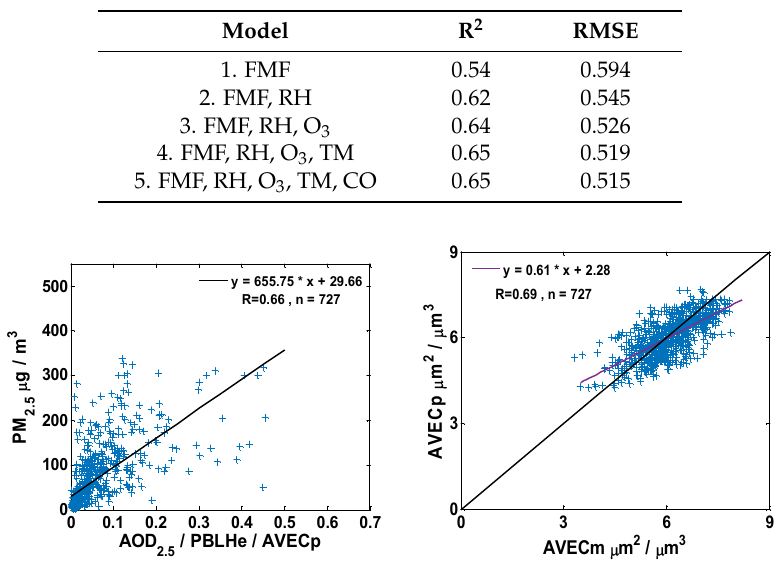
Table 3. Stepwise regression results with seven likely influence factors.